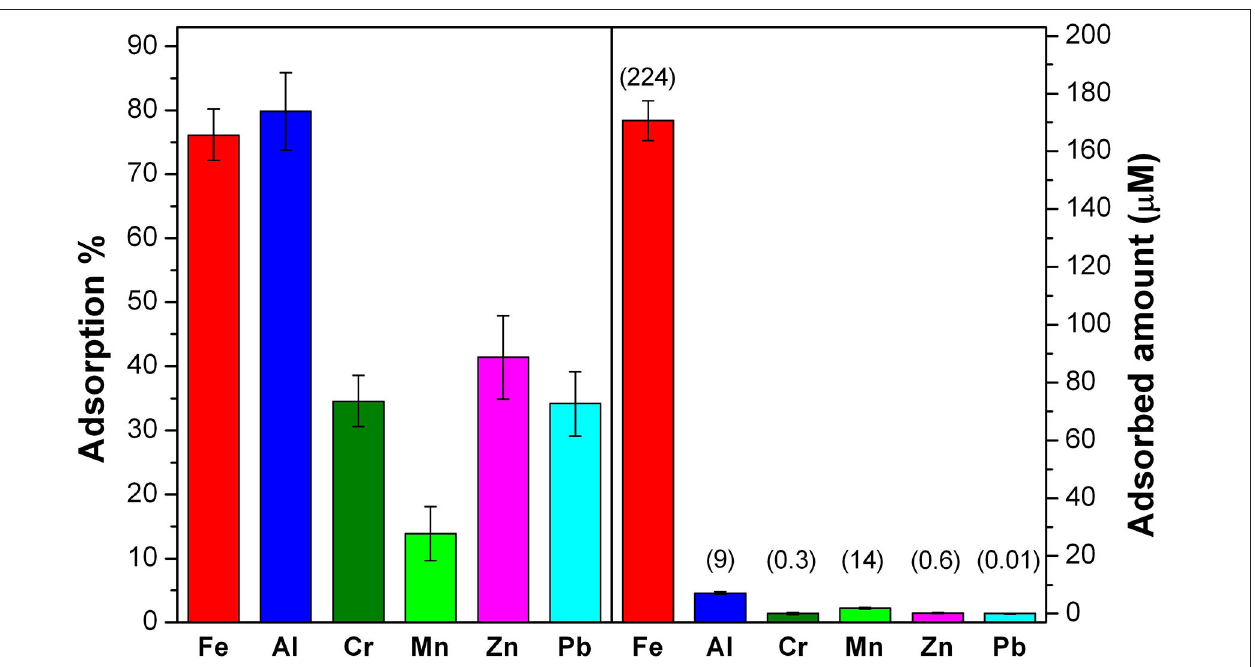
FIGURE 7 | Results of the 6 h-adsorption treatment of landfill leachate at its natural pH 5.6 with SBH-A. The left panel reports the adsorption % for each metal ion. On the right panel, the removed concentration ( µ M) of each ion is shown and the labels are referred to the starting concentration ( µ M) of each ion.